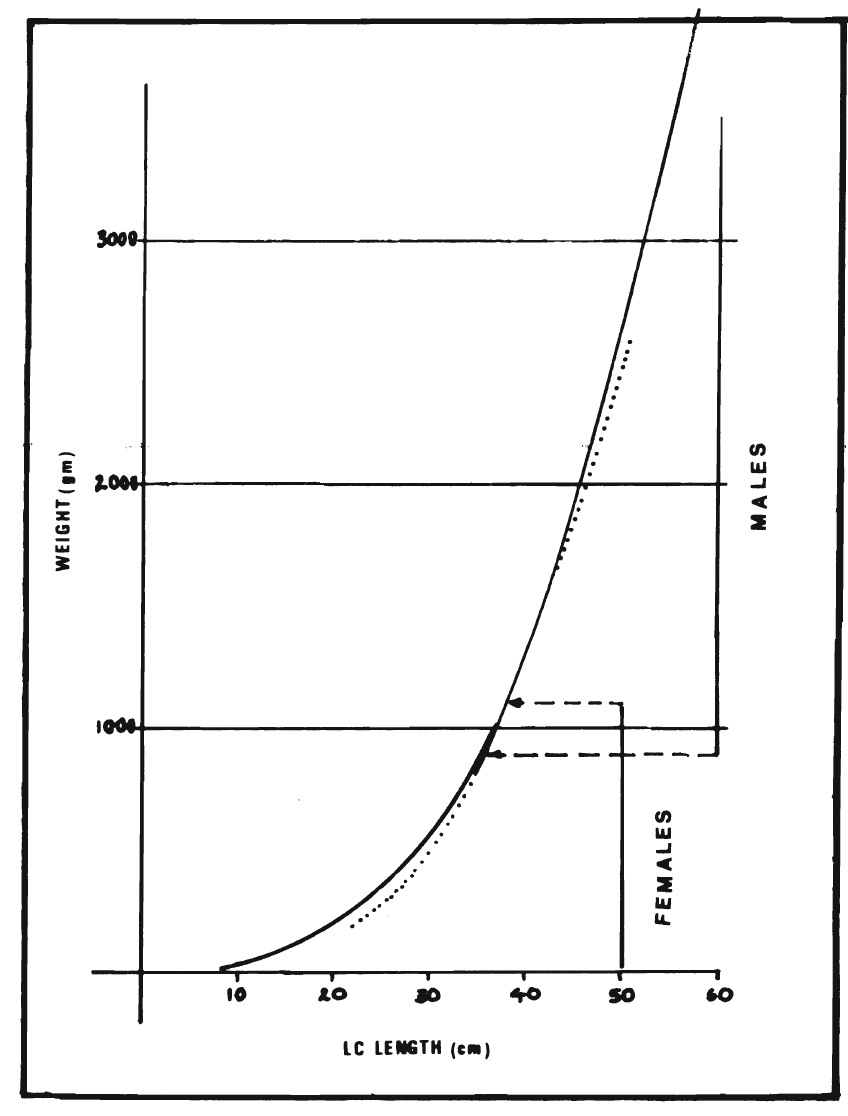
Fig. 2. Mass-length relationships for Chrysoblephus cristiceps 00 and